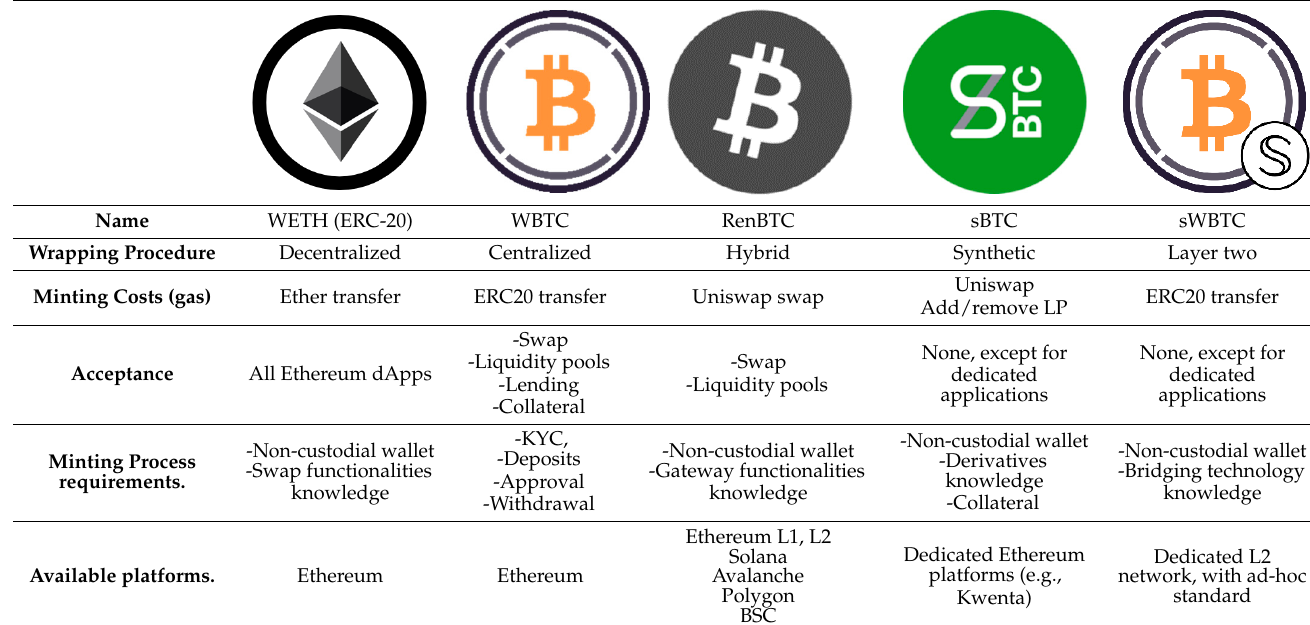
Table 7. Ease of use, acceptance, and cost of wrapping alternatives.